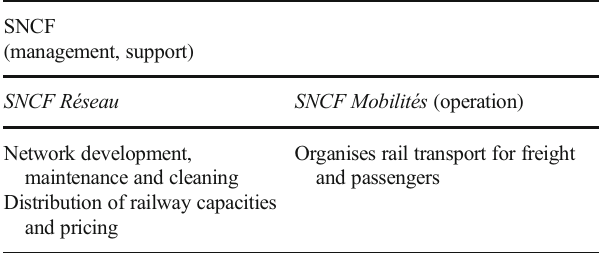
Division of railway activities between SNCF Réseau and SNCF Mobilités SNCF (management, support) SNCF Réseau SNCF Mobilités (operation) Network development, maintenance and cleaning Distribution of railway capacities and